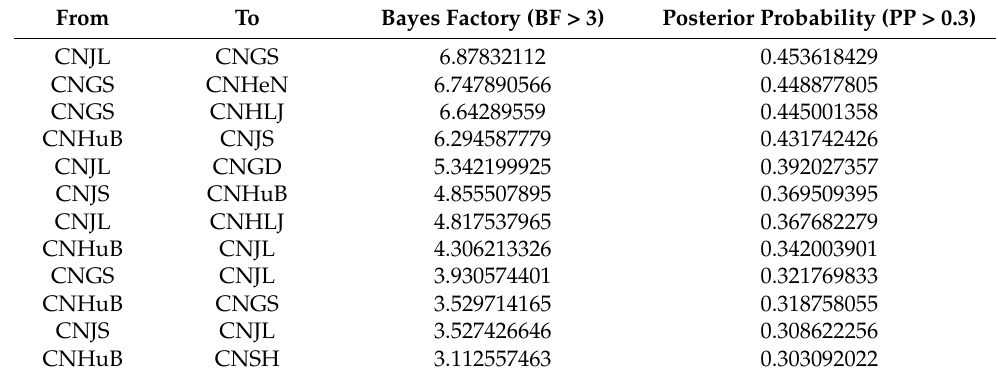
Table 2. Cont. From To Bayes Factory (BF > 3) Posterior Probability (PP > 0.3) CNJL